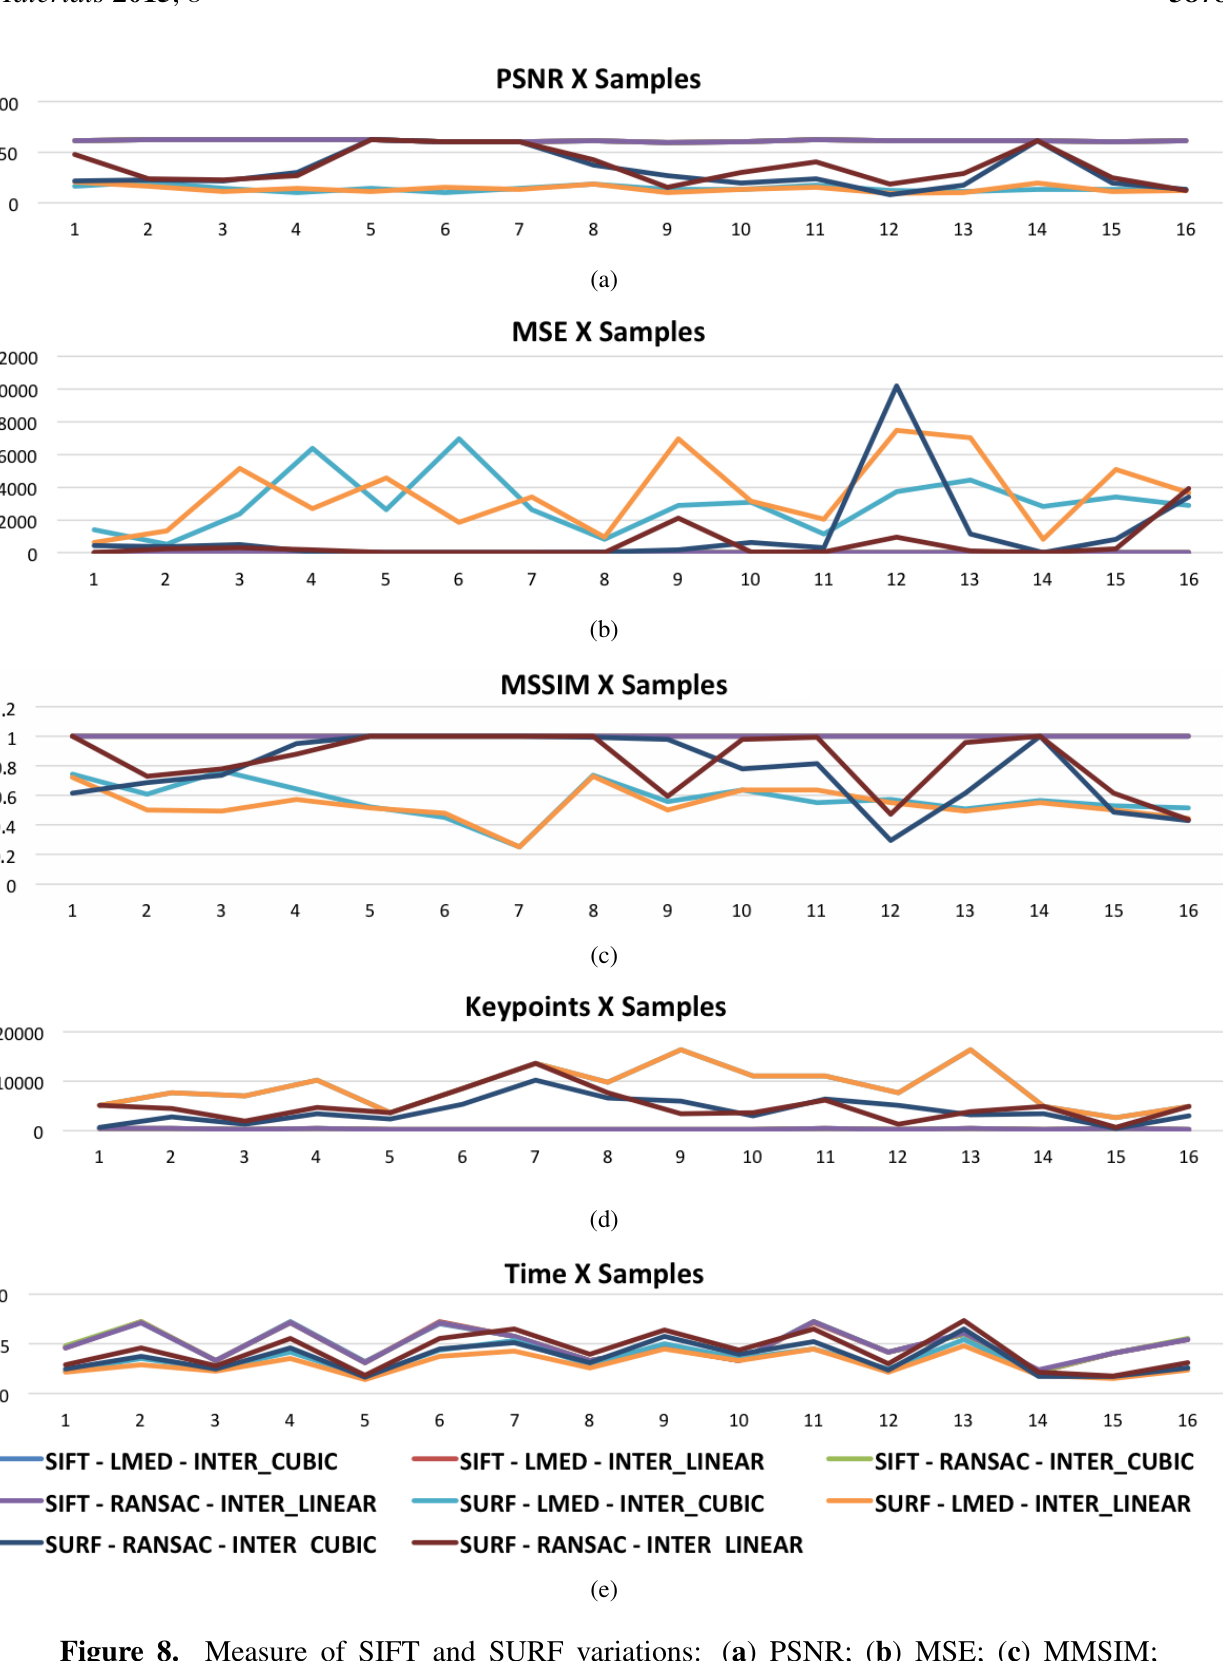
Figure 8. Measure of SIFT and SURF variations: ( a ) PSNR; ( b ) MSE; ( c ) MMSIM; ( d ) Number of keypoints and ( e ) time in seconds. As shown in Table 2, even with the large variation in the values of the metrics results, the SURF method is faster than the SIFT method. Although it has a higher speed in building the mosaic, its speed does not compensate for errors generated by the